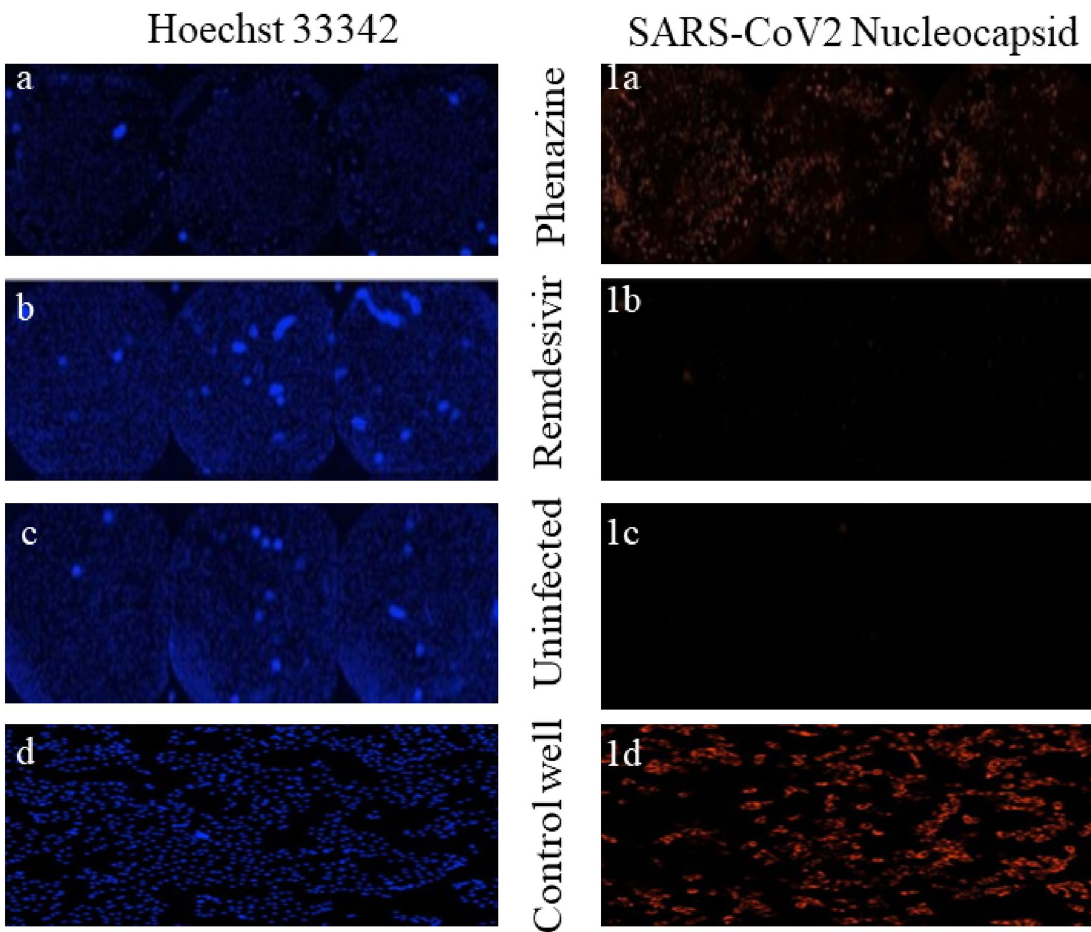
Figure 6. Representative morphological changes were observed in 1 × 10e4VeroE6 cells at the non-cytotoxic concentration of DAPH + Cl − and remdesivir using as revealed in Hoechst33342 staining (left) and nucleocapsid staining (right). [ a to a1 : VeroE6 cells infected virus treated with DAPH + Cl − ; b to b1 : VeroE6 cells infected virus treated with remdesivir; c to c1 : uninfected VeroE6 cells; d to d1: virus infected VeroE6